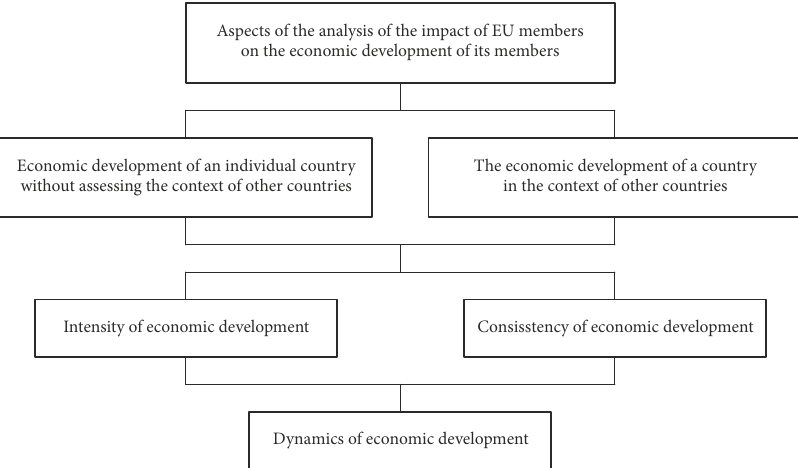
Figure 1. Scheme for analysing the impact of the European Union as an economic community on the economic development of its members (source: compiled by the